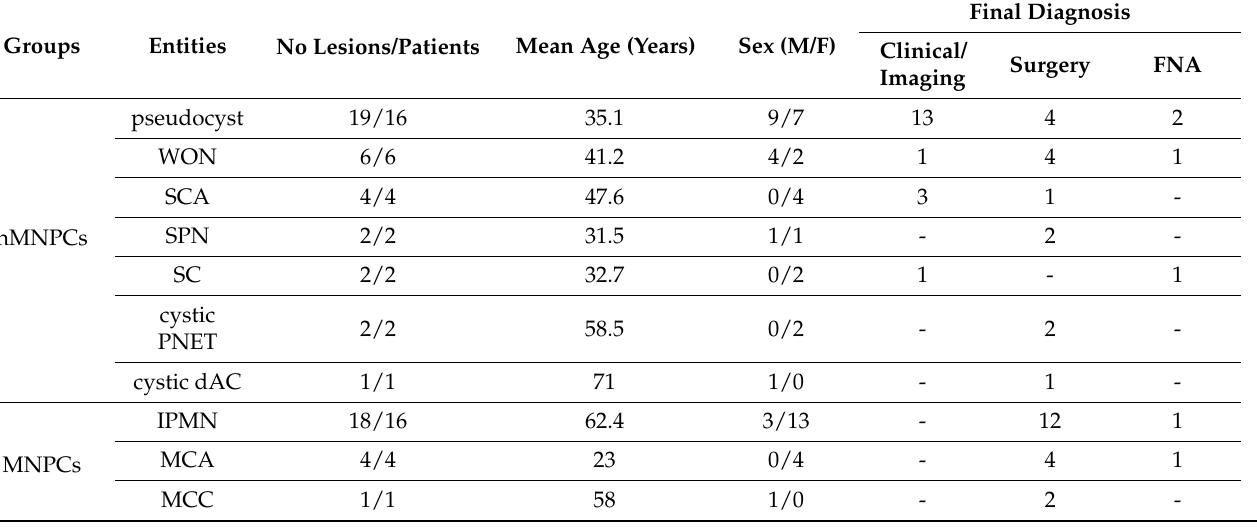
Table 2. Patients’ characteristics.